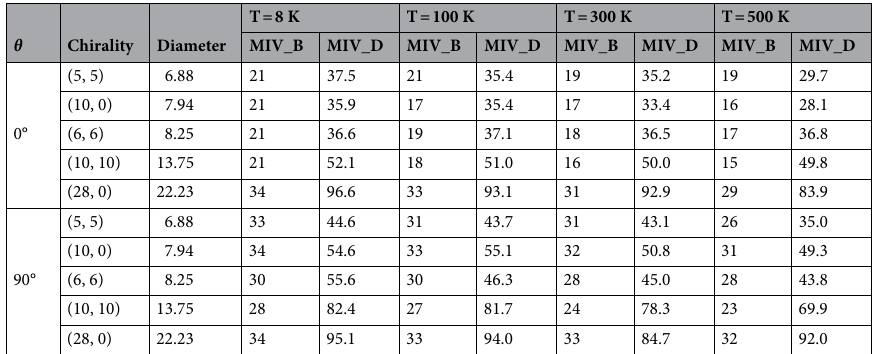
Table 1. Critical values of the incident velocity of C 60 colliding with nanobeams at different conditions. Both the minimal incident velocities with respect to buckling beam ( MIV_B ) and with respect to damaged beam ( MIV_D ) of each case are listed. Unit of dimension: . Unit of velocity: Å